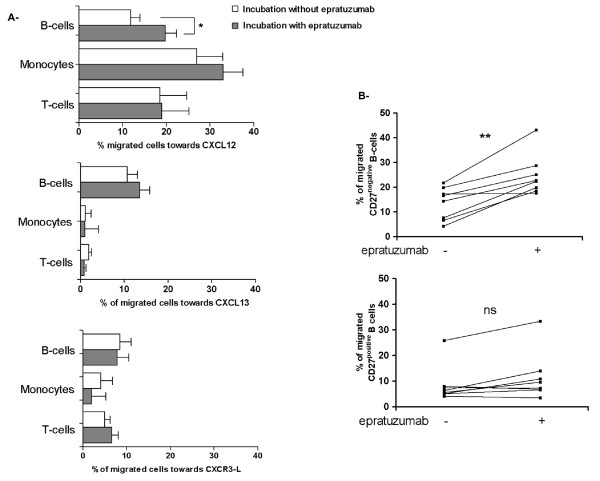
Enhanced migration of CD27negative B-cells from SLE patients towards CXCL12 after epratuzumab incubation. To assess the migration towards CXCL12, CXCL13 and CXCR3 ligands of PBMCs from eight SLE patients, we performed transwell migration assays after epratuzumab incubation (10 μg/mL for 90 minutes). The migration of different cell types towards CXCL12 was analyzed by flow cytometry [(T-cells, CD3positive), (monocytes, CD14positive), (total B-cells CD19positive); CD27negative B-cells CD27positve B-cells] and epratuzumab incubation lead to a significantly enhanced migration of B-cells (a) (*P < 0.05). No effect of epratuzumab was observed on T-cells and on monocytes. Migration of all cell types, including B-cells, towards CXCL13 and CXCR3 ligands was unaffected by epratuzumab. (b) Studies of CD27negative and CD27positive B-cells from SLE patients revealed that the increased migration toward CXCL12 was primarily restricted to CD27negative B-cells (** P < 0.01).